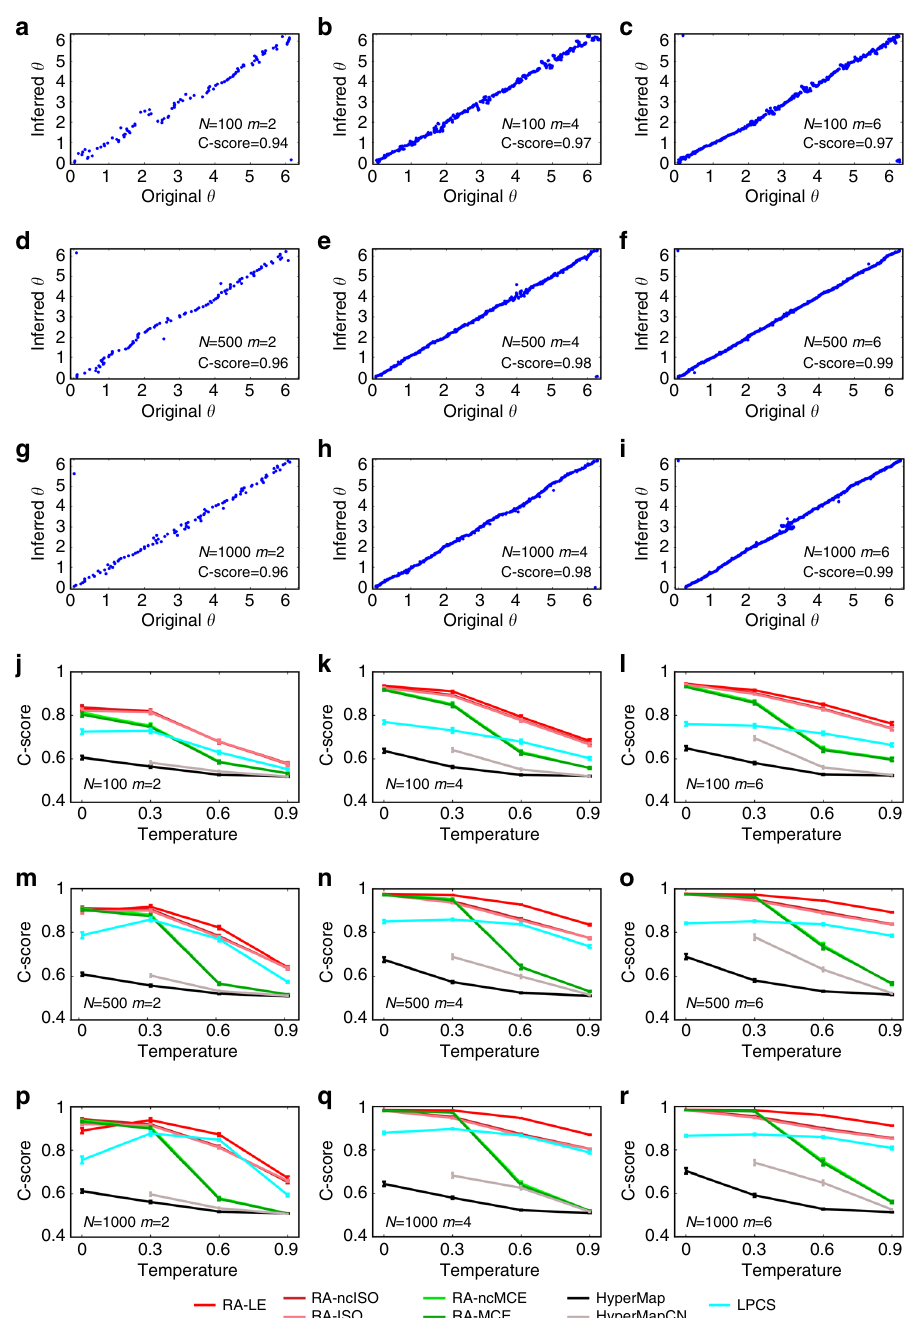
Fig. 4 Angular coordinates comparison and C-score on popularity-similarity-optimization synthetic networks. a – i For all the combinations of the PSO parameters N (size) and m (half of average degree), we chose among the synthetic networks embedded with RA-MCE-EA the ones with the best C-score, which had always temperature T = 0. For these networks, we plotted the aligned inferred angular coordinates against the original angular coordinates ( θ ). The alignment was done in the following manner: we applied 360 rotations of one degree both to the inferred coordinates as they are and to the inferred coordinates obtained arranging the nodes in the opposite clock direction. Then from these resulting 720 alternatives of the inferred angular coordinates, we chose the one that maximizes the correlation with the original angular coordinates, in order to guarantee the best alignment. The alignment does not change the C-score, which represents the percentage of node pairs in the same circular order in the original and inferred networks (see “ Methods ” section for details). Similar plots for the other coalescent embedding methods and temperature values can be found in Supplementary Figs. 8 – 17. j – r The plots report the average C-score and the standard error over the 100 synthetic networks that have been generated for each different parameter combination. There are no separate plots for the methods with and without EA since this adjustment affects the distances but not the circular ordering, therefore it does not change the C-score. For each subplot, the value of HyperMap-CN for T = 0 is missing because the original code assumes T >